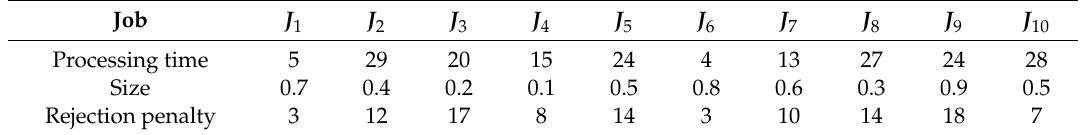
Table 1. The processing times, sizes and reject penalties for the given 10 job.